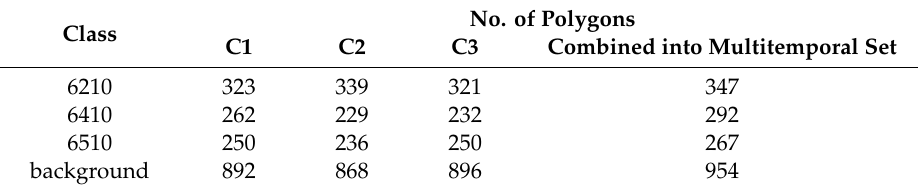
Table 3. Number of polygons collected for each campaign and in combined multitemporal reference dataset for each habitat and associated background (C1, C2, C3—campaign